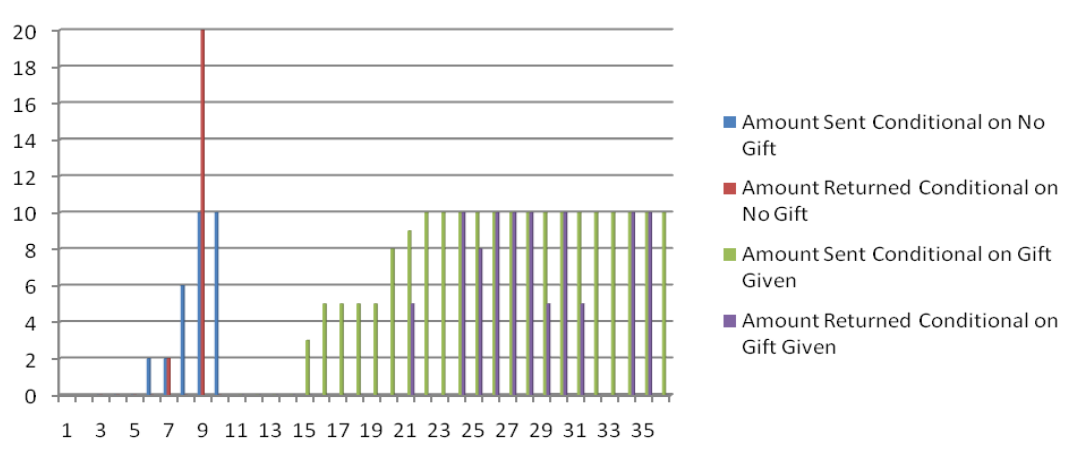
Figure 3. Subjects’ Behavior in Endowment